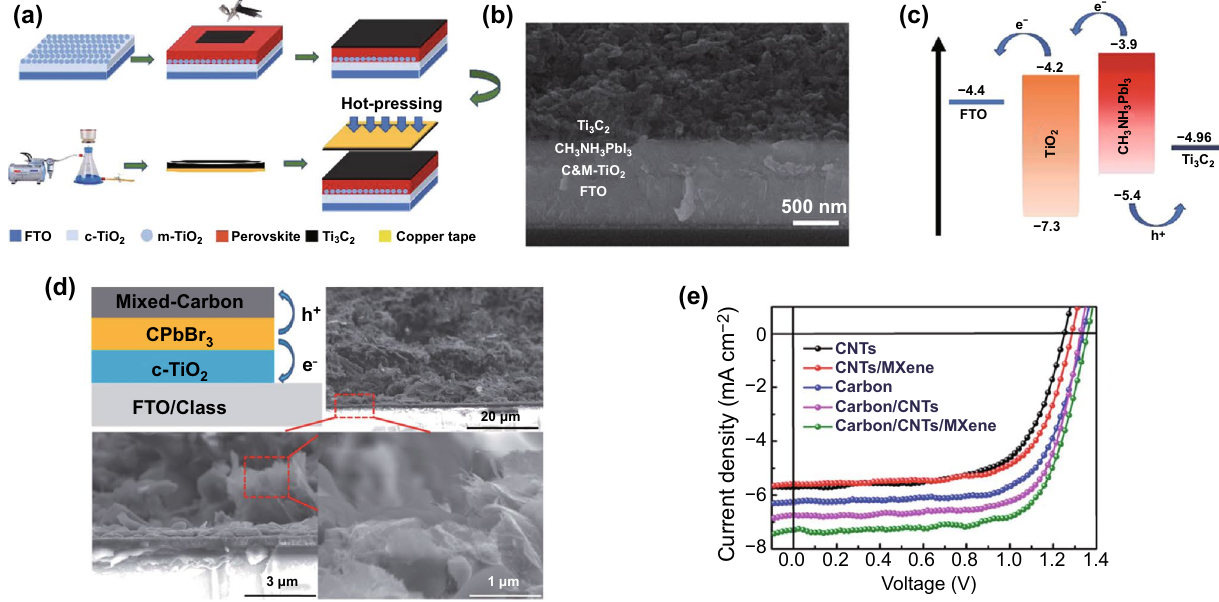
Fig. 5 a Fabrication process of the MAPbI 3 -based PSCs with a Ti 3 C 2 T x back electrode prepared using a hot-pressing method. b Cross-sectional SEM image and c energy-level alignment of each component for the MAPbI 3 -based PSCs. Copyright © 2019 The Royal Society of Chemistry. d Device configuration of the CsPbBr 3 -based solar cells using the mixed carbon electrode and cross-sectional SEM images of the mixed carbon electrode. e Illuminated J – V curves of the solar cells with different types of electrodes. Copyright © 2020 The Royal Society of